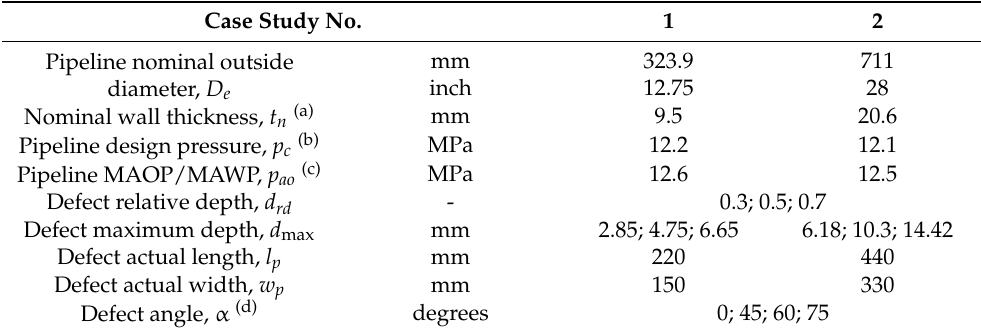
Table 2. Case studies: pipeline and defect data. Case Study No.